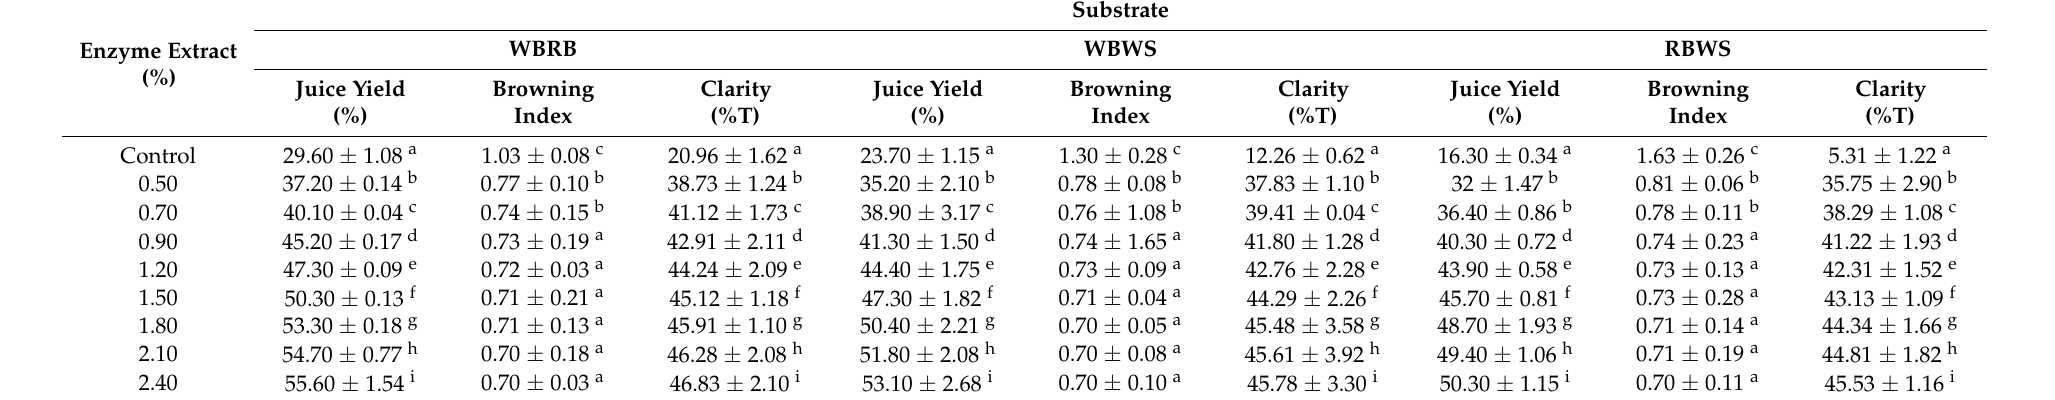
Table 3. Effect of purified enzyme extract on characteristics of pumpkin juice 1